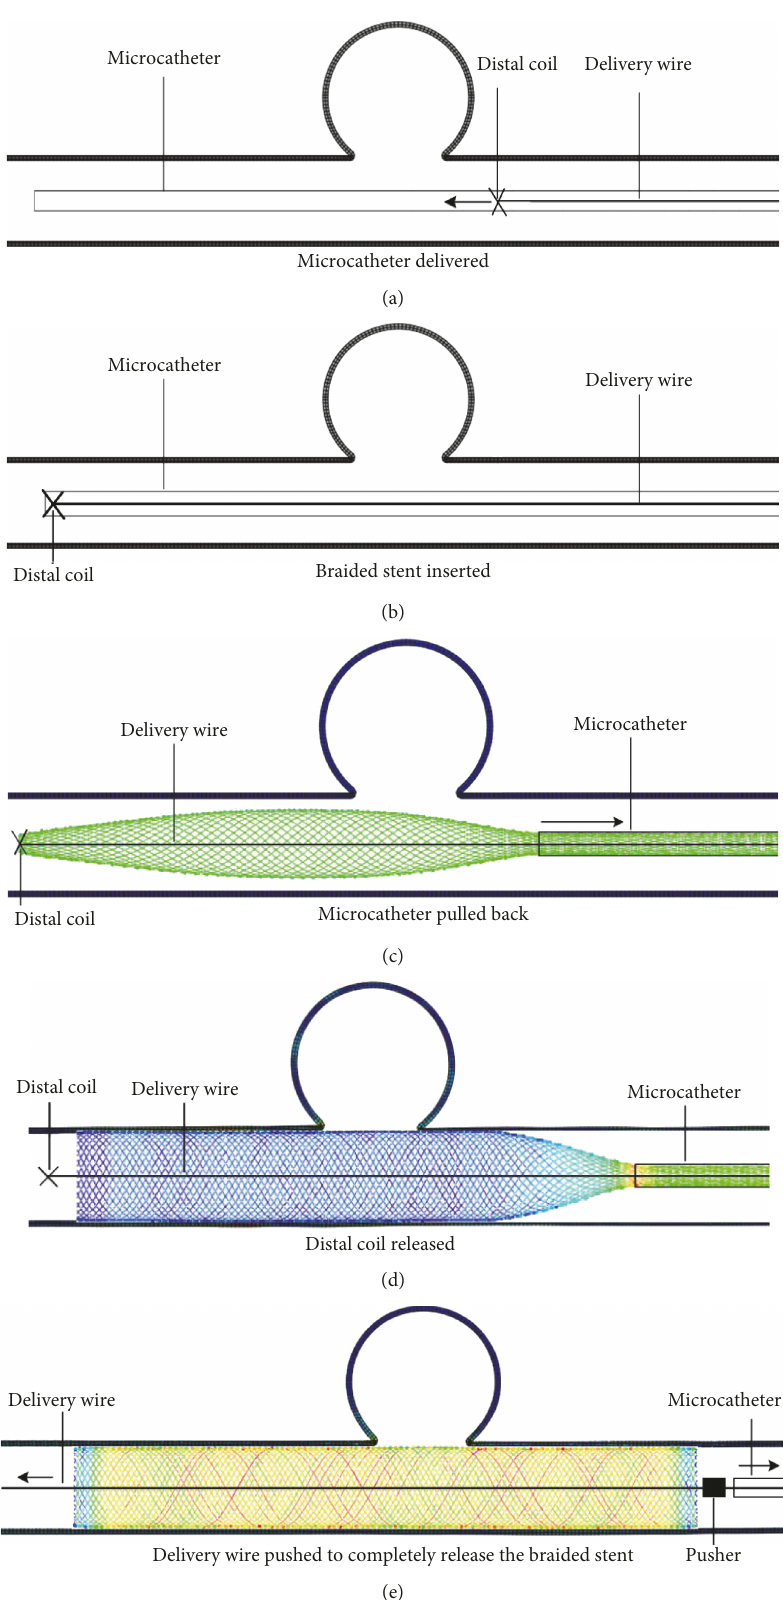
Figure 4: Deployment procedure of fl ow diverter without